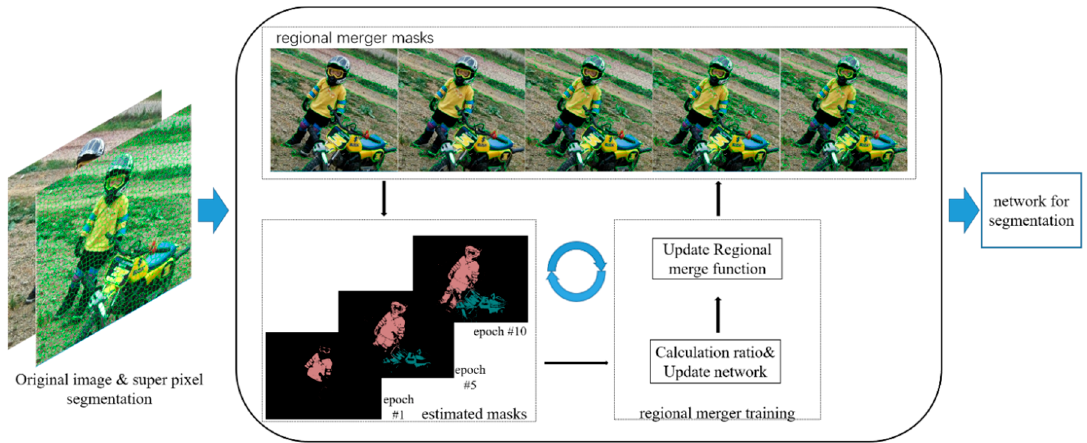
Figure 1. The flow chart of supervision training based on regional merging neural network (RMNN).